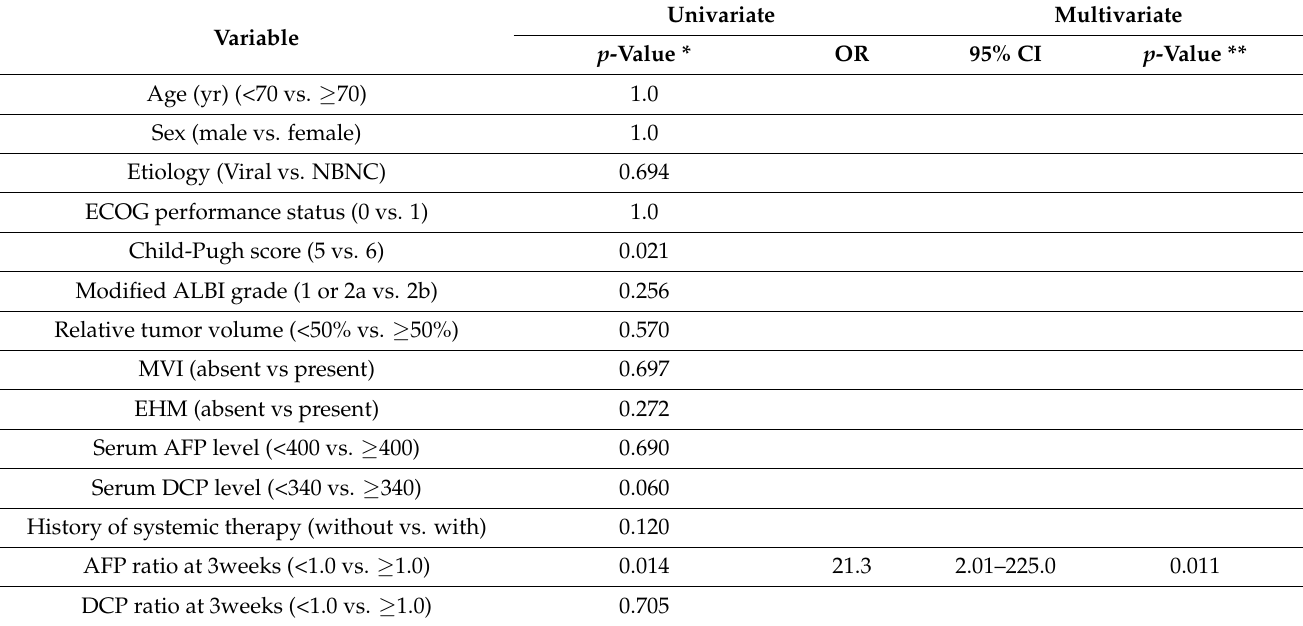
Table 4. Univariate and multivariate analyses of predictive factors for response at first evaluation in atezolizumab plus bevacizumab combination